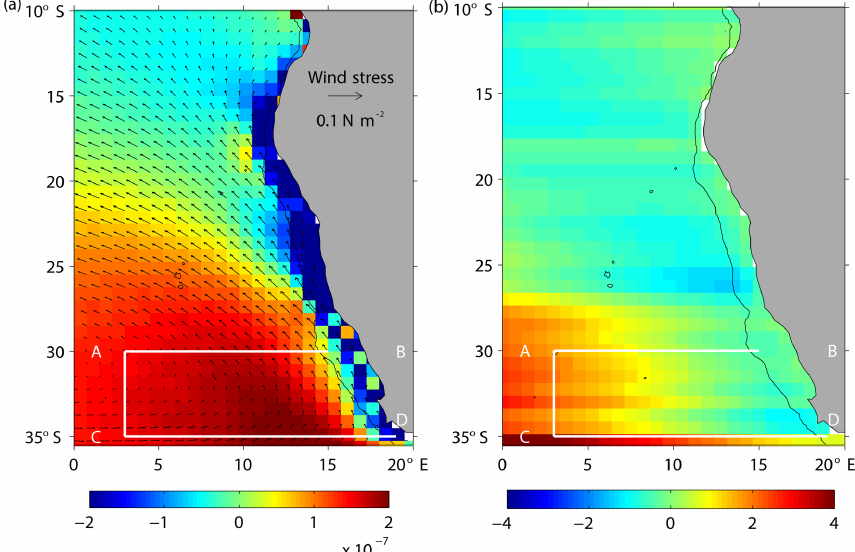
Figure 9. (a) Climatologies of ERA interim wind stress curl (in color) and the wind stress (arrows). (b) Climatology of the Sverdrup stream function (color).